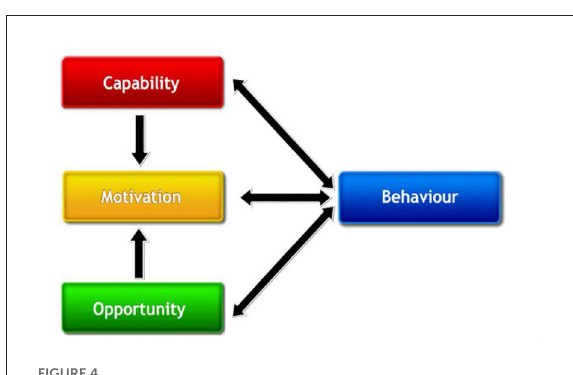
FIGURE4 Capability-Opportunity-Motivation-Behavior (COM-B) Model (Michie et al., 2011,